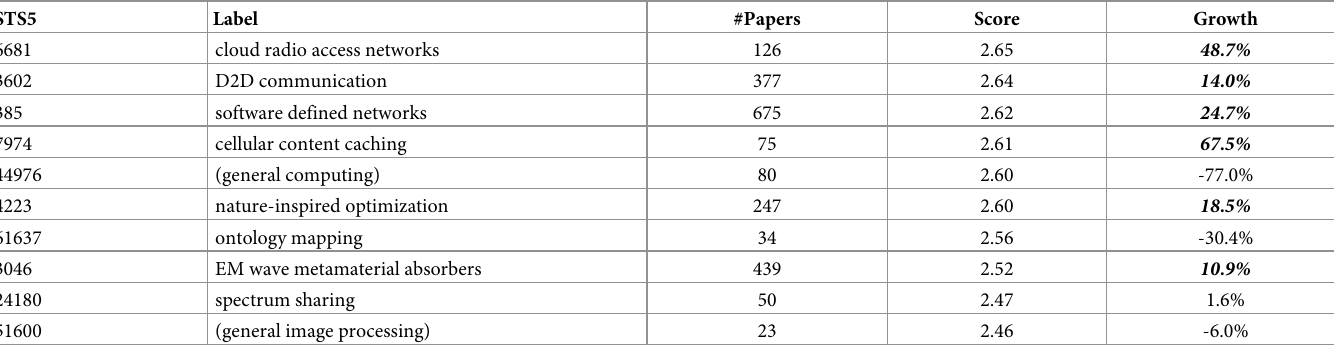
Table 9. Top 10 forecasted STS5 RCs from the Computing Technology field (FY = 2014, TY = 2017, RY = -4, #papers in 2014 > = 20).